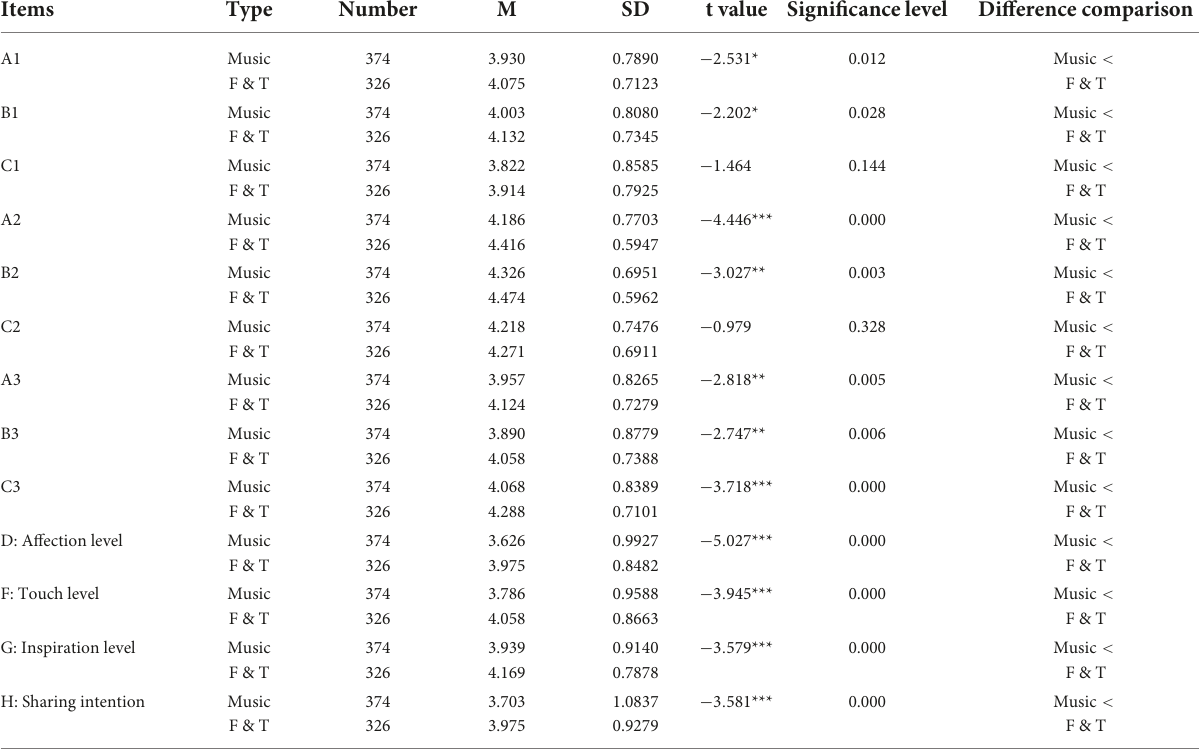
TABLE 9 The table of analysis of differences in testers’ perception of emotional design.